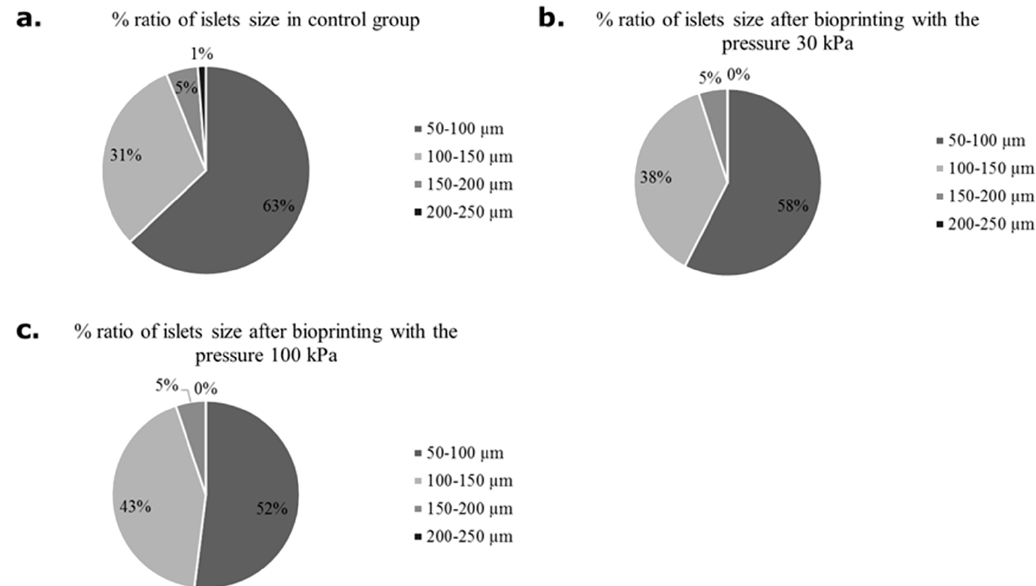
Figure 6. Number of pancreatic islets in various sizes subjected and non-subjected to the bioprinting process with different pressures and a nozzle with an internal diameter of 0.6 mm. As a carrier material, 3 % ( w/v ) alginate was used. Islets were stained by dithizone and measured individually. Our control group were pancreatic islets 24 h after isolation. Photographs of islets before and after bioprinting process are presented in Figure 7.